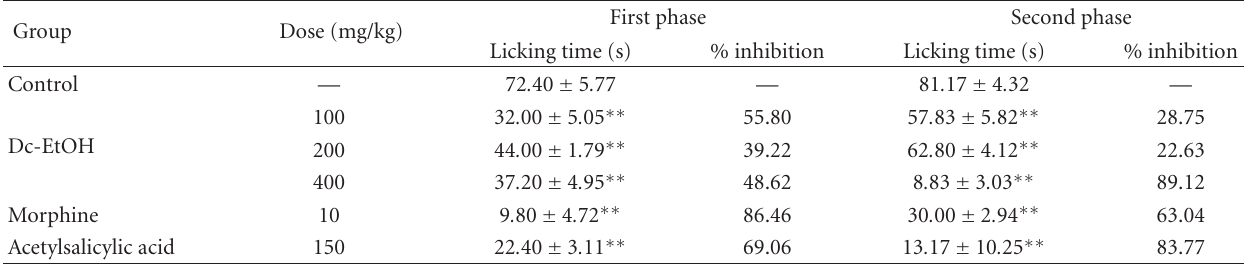
Table 2: E ff ect of Dc-EtOH on formalin-induced pain in mice.